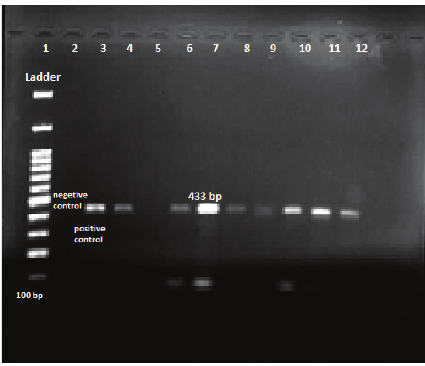
Figure 2: PCR product of PVL gene (agarose 1.5%). Lane Ladder: molecular size marker. Lane 3: positive control for PVL gene (433 bp). Lane 2: negative control. Lanes 4 and 6–12: positive isolate from patient For PVL gene.